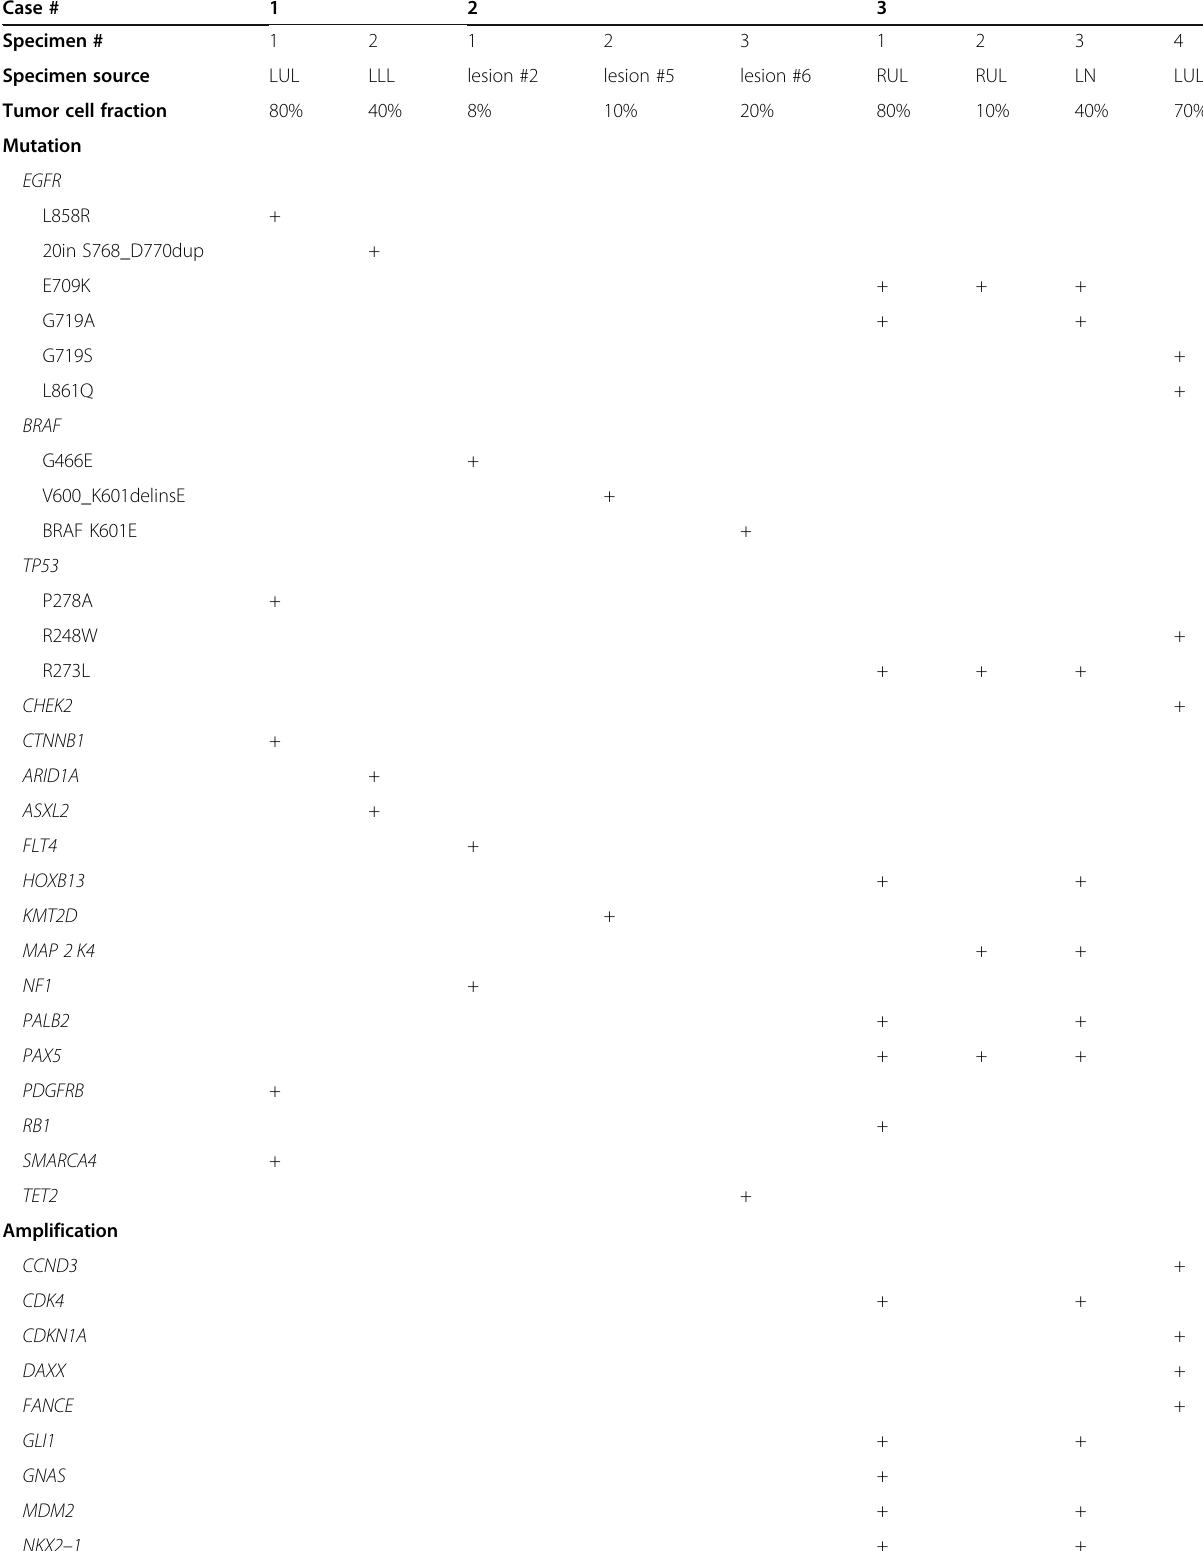
Table 1 Genomic alterations detected by NGS profiling of pulmonary resections from three